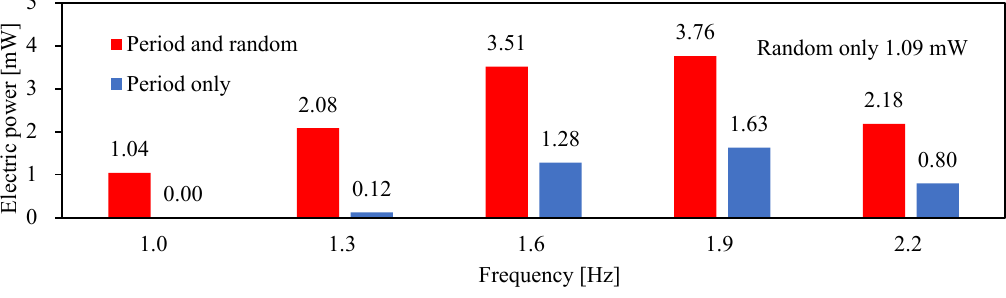
Figure 24. Effect of periodic excitation frequency on power output.